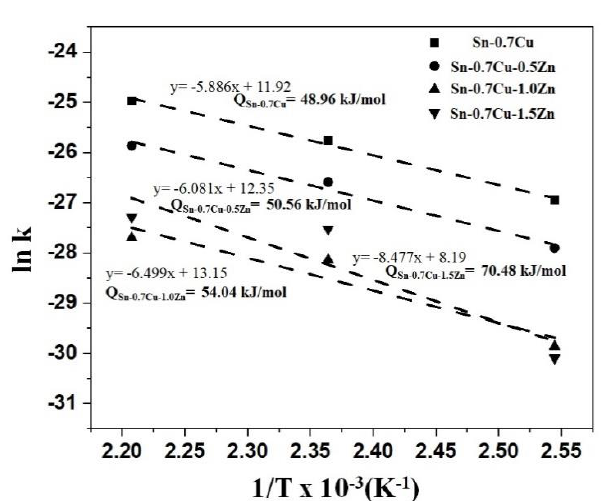
Figure 13. Arrhenius plots of ln k vs. 1/T for the IMC growth kinetics for Sn-0.7Cu- x Zn.